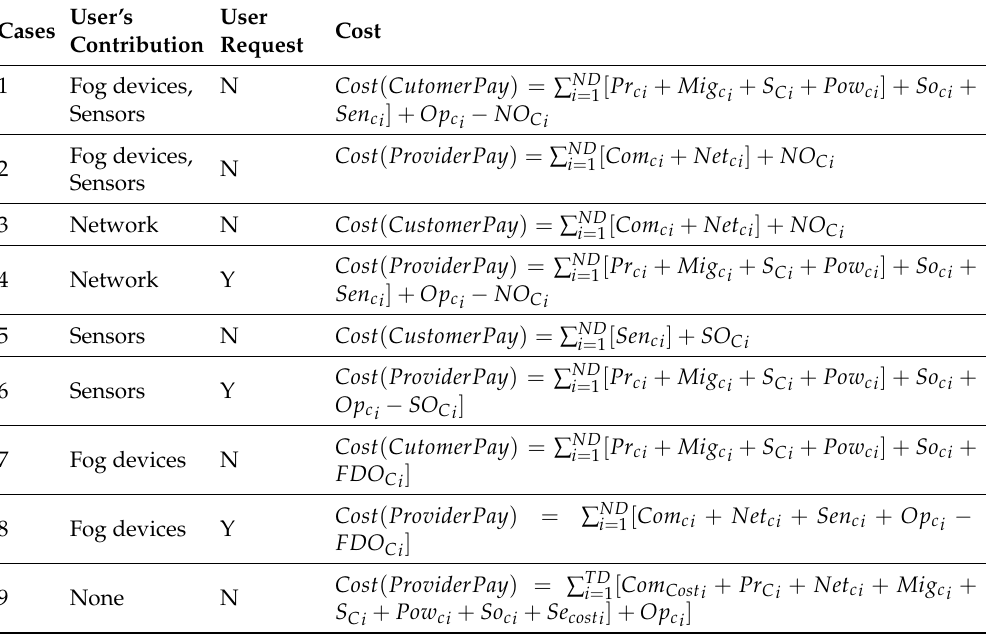
Table 1. Different cases of users and providers